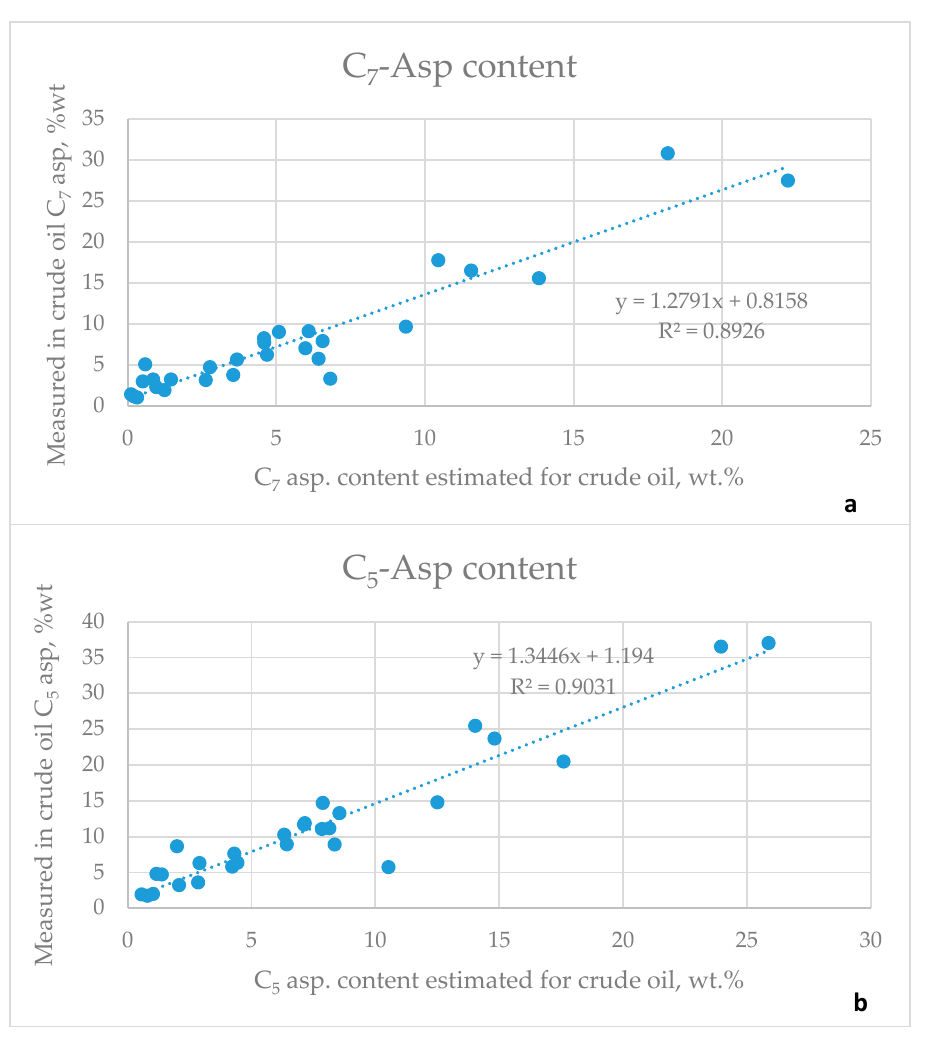
C asp. content estimated for crude oil, wt.% 5 Figure 3. Measured versus estimated C 7 - ( a ) and C 5 - ( b ) asphaltene contents using the additive rule.